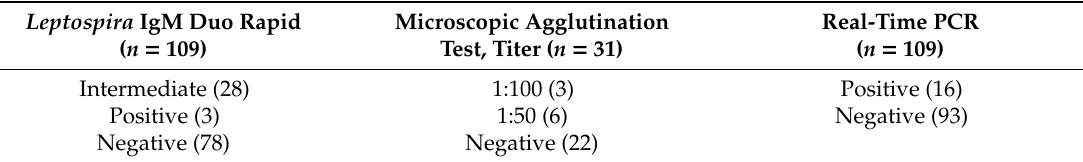
Table 2. Results of serological and real-time PCR.